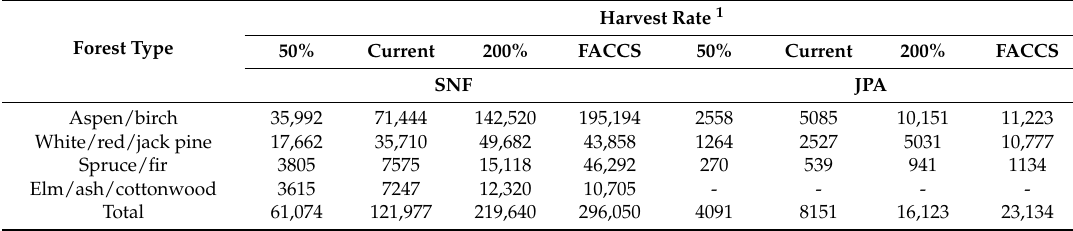
Table 3. Estimated annual biomass availability (Mg) by forest type on the Superior National Forest (SNF) and Jeanette Project Area (JPA) under current disturbance levels.